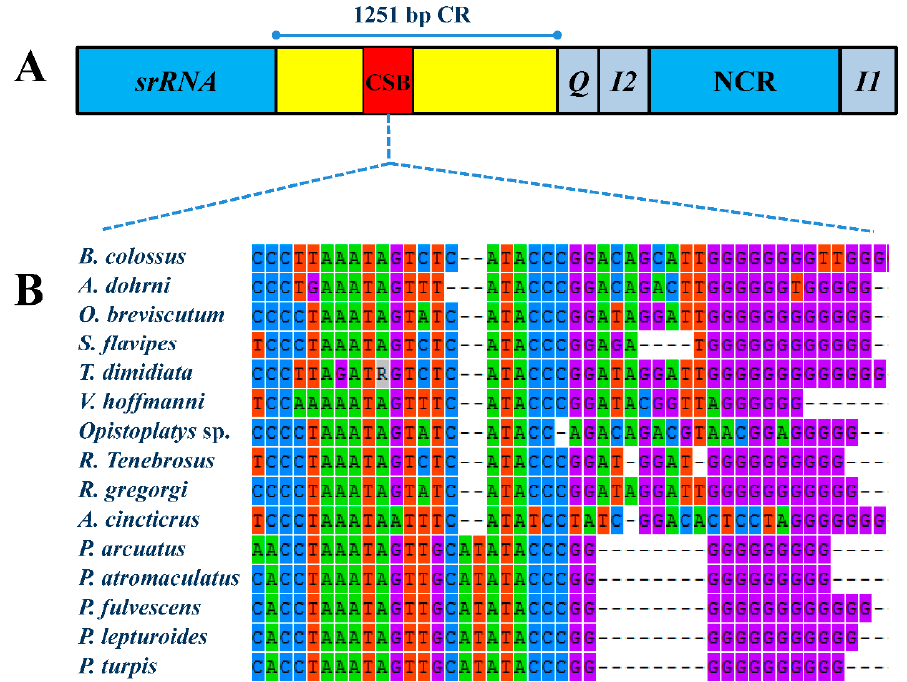
Figure 3. The conserved sequence block in the control region of assassin bug mt genomes: ( A ) the organization of the control region in the R. tenebrosus mt genome; and ( B ) the conserved sequence block in the control region of the sequenced assassin bug mt genomes. CR is the abbreviation for control region and CSB is the abbreviation for conserved sequence block. Four bases are labeled in different colors: Adenine (A)—green, Guanine (G)—purple, Thymine (T)—red and Cytosine (C)—blue.